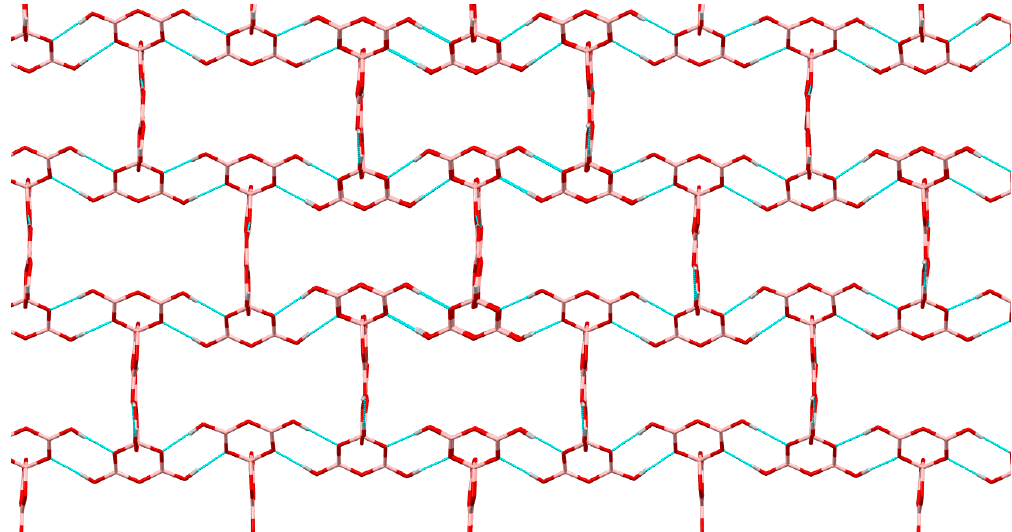
Figure 3. Giant lattice arising from pentaborate(1-)-pentaborate(1-) interactions in 2 , viewed along the a axis. Cations have been omitted for clarity, but are situated within ′ cavities ′ . Within this ′ plane ′ each pentaborate(1-) in shown H-bonding to 3 other pentaborate(1-) anions by R 22 (8) interactions. The fourth R 22 (12) interaction is not visible from this view.